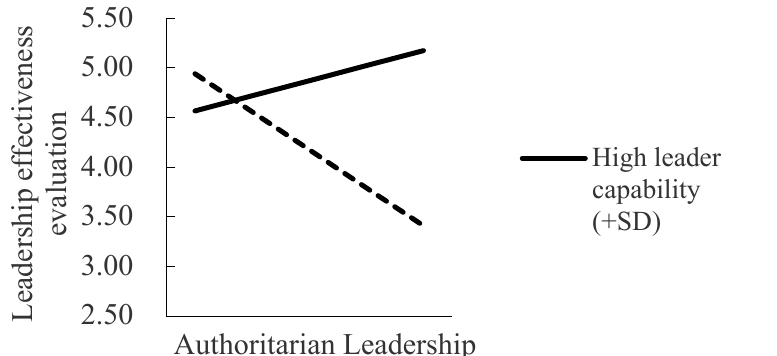
Figure 2. The relationship between authoritarian leadership and leader effectiveness under the conditions of low and high leader capability.